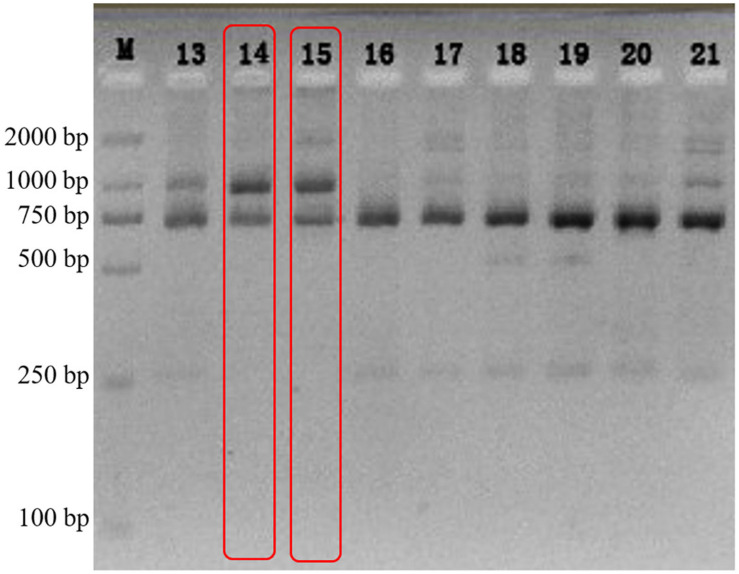
The electrophoretogram of n18S-rDNA TaqI-generated RFLPs from G. fascicularis DNA.